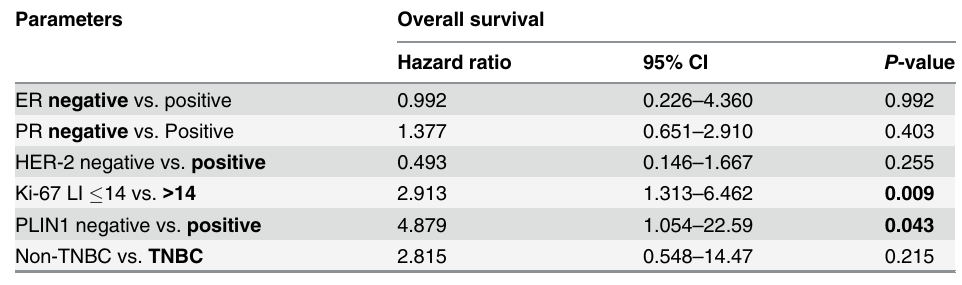
Table 6. Multivariate analysis of patient prognoses in metastatic breast